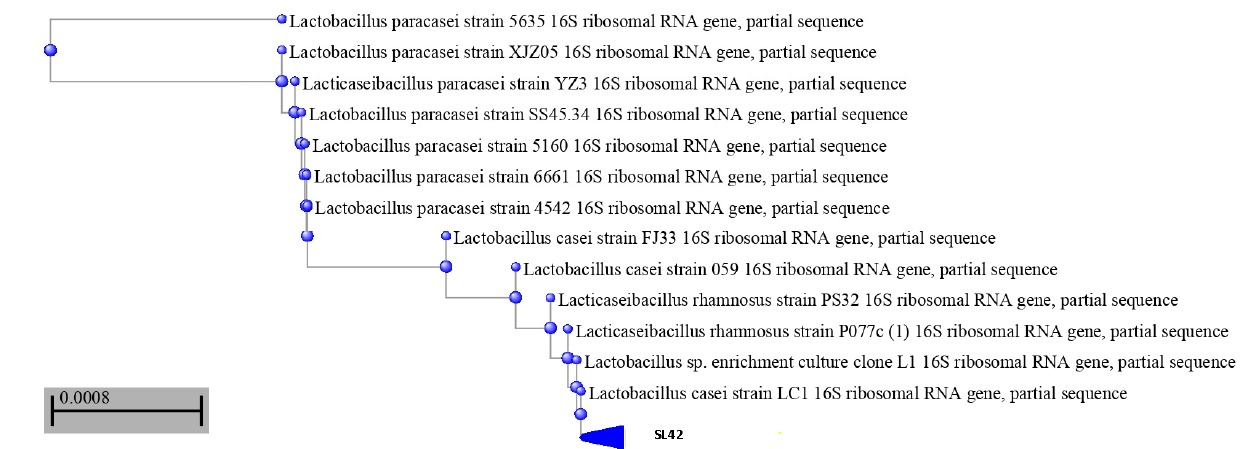
Figure 2. Constructed phylogenetic tree showing the position of the isolated SL42 with related Lactobacillus species.